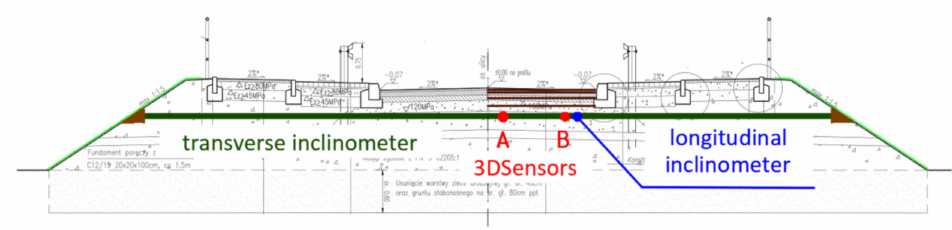
Figure 24. Cross-section of the embankment at the location of transverse inclinometer.